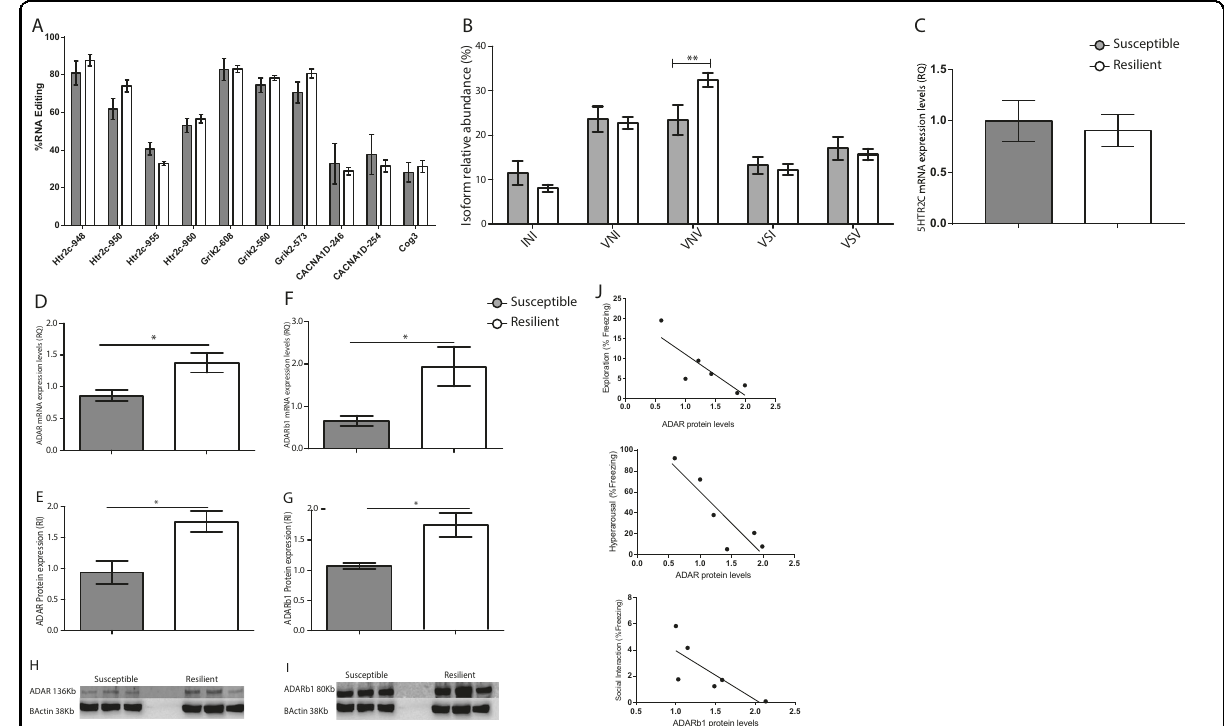
Fig. 2 Targeted sequencing by mmPCR revealed differential RNA editing of the 5-HT2CR in the CeA of susceptible compared to the resilient group. ( A ) The ten RNA editing sites common to both experimental groups that passed the de fi ned criteria. No signi fi cant differences were found between the experimental groups ( p > 0.05) in RNA editing levels in the sites of the 5-HT2CR, Grik2, CACNA1D, and Cog3. ( B ) Relative abundance of the 5-HT2CR mRNA variants produced by RNA editing. Data show a relatively higher abundance of the VNV isoform (* p < 0.05) in the resilient animals than in the susceptible group. Data presented as mean + SEM; n = 7 – 13 per group. ( C ) mRNA expression levels of the 5-HT2CR did not reveal a signi fi cant change between the experimental groups ( p > 0.05). ( D , F ) qPCR analysis revealed signi fi cantly higher expression levels of ADAR ( D ) and ADARb1 ( F ) in the resilient group compared to the susceptible group (* p < 0.05). Data presented as mean + SEM; n = 6 7 per group. ( E , G – I ) Protein expression of ADAR ( E , H ) and ADARb1 ( F , I ) analyzed by western blot with speci fi c antibodies against ADAR , ADARb 1 and β -Actin as a loading control revealed a signi fi cantly elevated expression of these proteins in the resilient animals compared to the susceptible group (* p < 0.05). Data presented as mean + SEM; n = 3 per group. ( J ) Pearson ’ s correlation between ADAR proteins and freezing behavior at the second reminder time point presenting a high correlation between: ADAR and exploration ( r = − 0.7, p = 0.04), ADAR and hyperarousal ( r = − 0.7 and p = 0.02), and ADARb1 and social interaction ( r = − 0.6 and p =